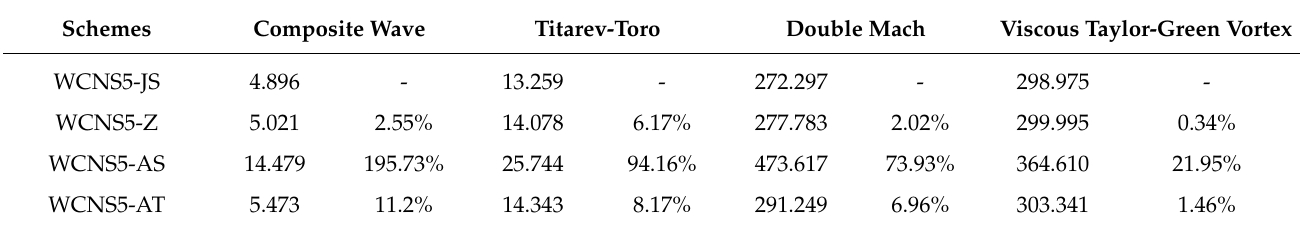
Table 3. CPU time (unit: s) and time increment (compared with the WCNS5-JS scheme).